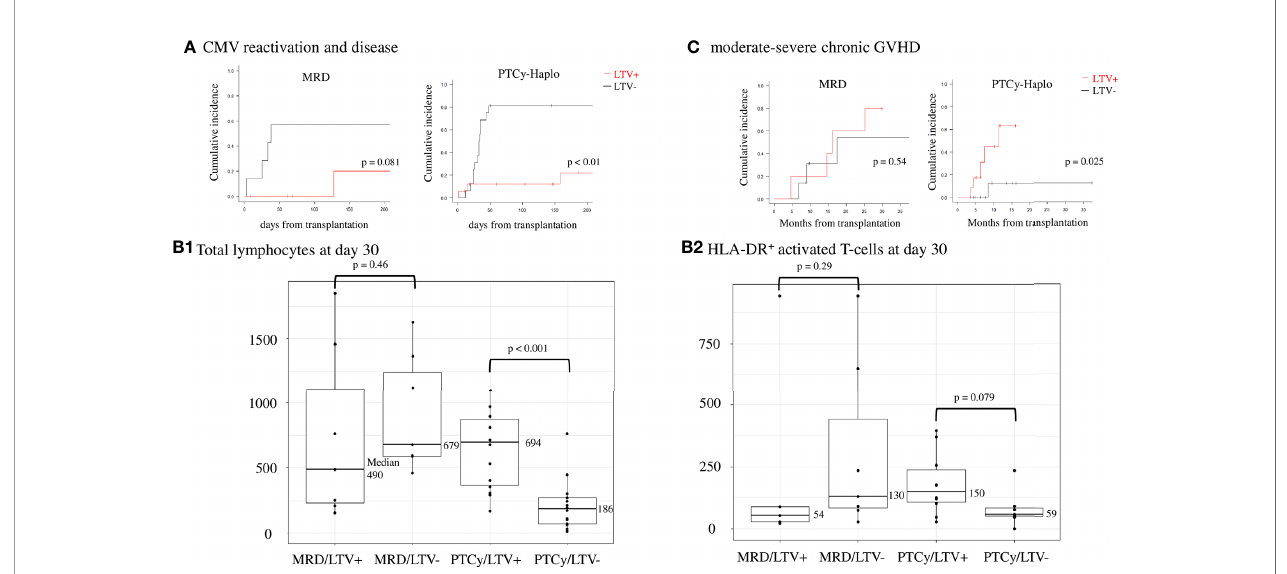
FIGURE 1 | Effects of CMV prophylaxis with LTV in matched related donor (MRD) transplantation and haploidentical transplantation with post-transplant cyclophosphamide (PTCy-haplo). (A) CMV reactivation and disease rate at day 100 in MRD and PTCy-haplo transplant recipients. Statistical analysis was performed using the Kaplan − Meier method with log-rank analysis and Gray ’ s test. (B) Counts of total lymphocytes (left, B1 ) and HLA-DR + activated T-cells (right, B2 ) in MRD and PTCy-haplo transplant recipients treated or not with LTV. Statistical analysis was performed using the Mann − Whitney U test. (C) Development of moderate-to- severe chronic GVHD at 15 months in MRD and PTCy-haplo